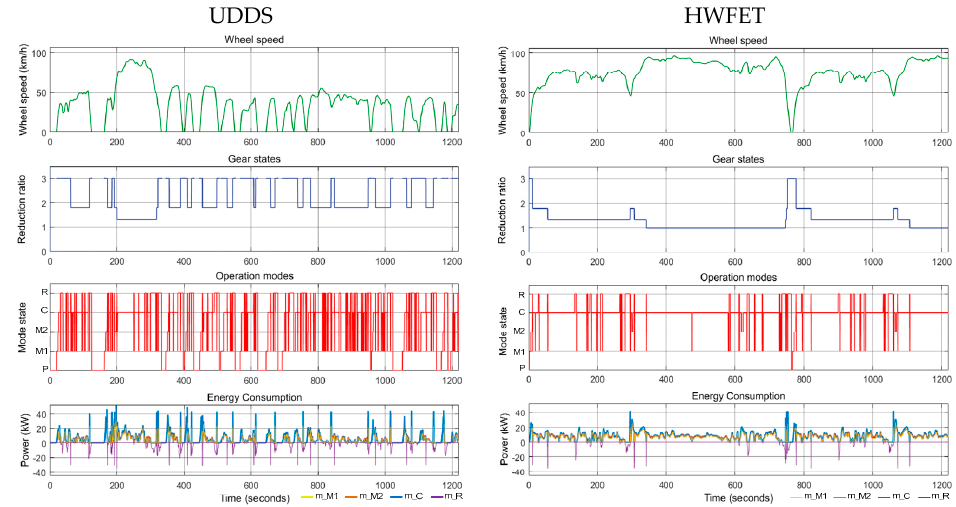
Figure 16. The simulation results of Urban Dynamometer Driving Schedule (UDDS) and Highway Fuel Economy Test (HWFET).